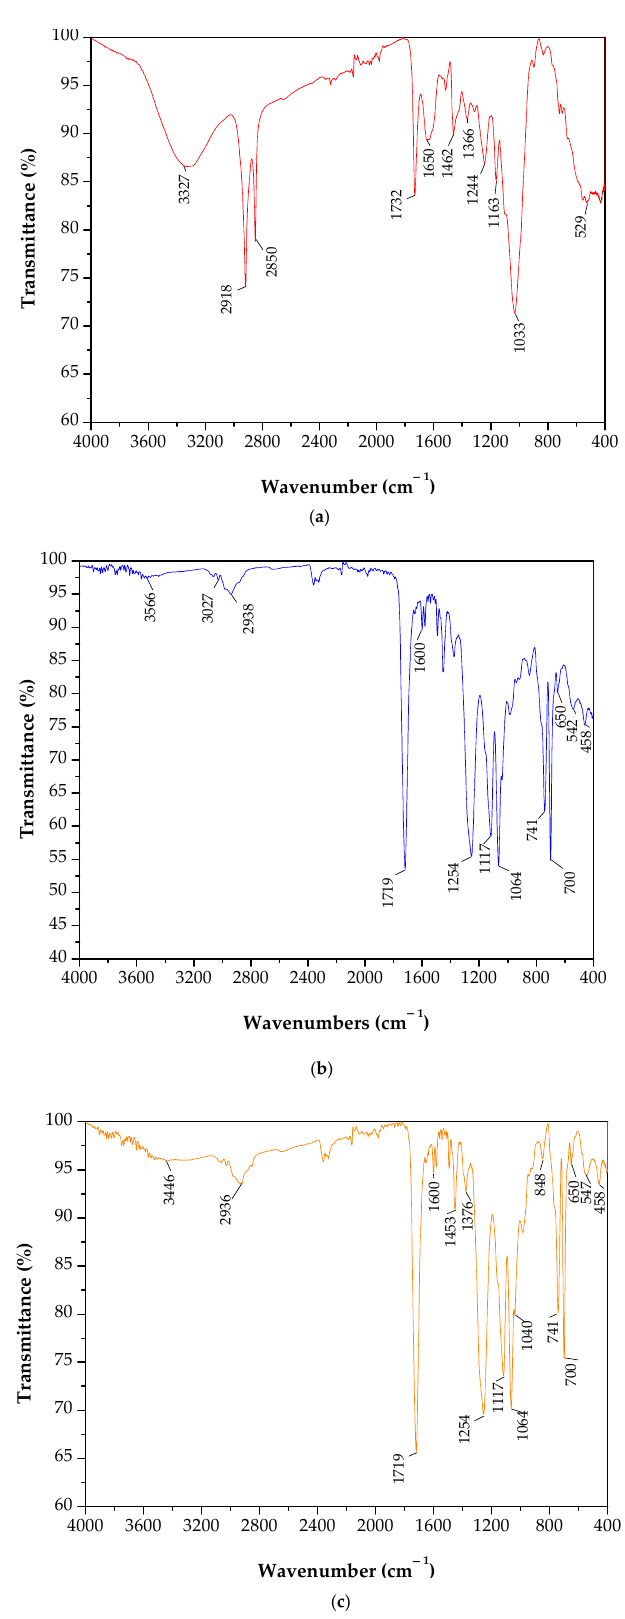
Figure 12. FTIR spectra of raffia fiber and its composites: (a) raffia fiber; (b) polyester; and (c) raffia composite.